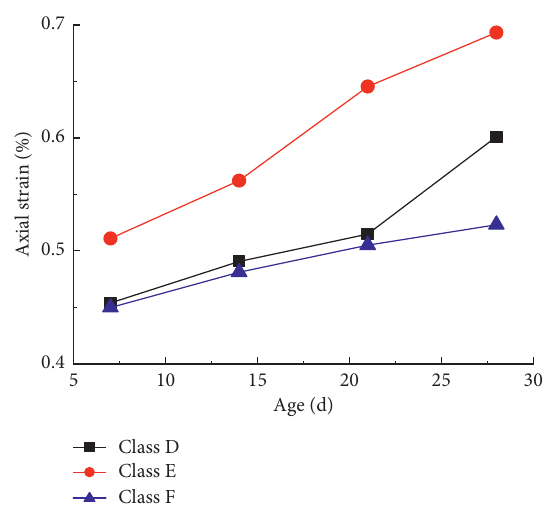
Figure 13: Axial strain curve of reinforcing cement paste.